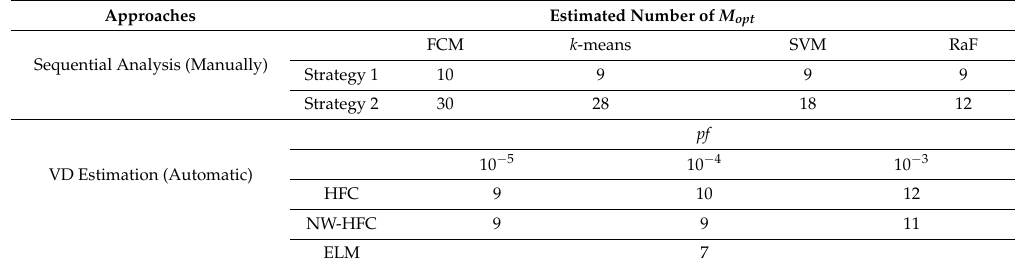
Figure 17. Computational cost in two proposed supervised CD approaches based on different X S (mean with standard deviation), in comparison with the ones based on X D and two reference methods. Note that the time cost for band selection is included in the proposed approaches (Umatilla County dataset). Table 7. Estimation of the optimal number of selected bands (Umatilla county dataset).